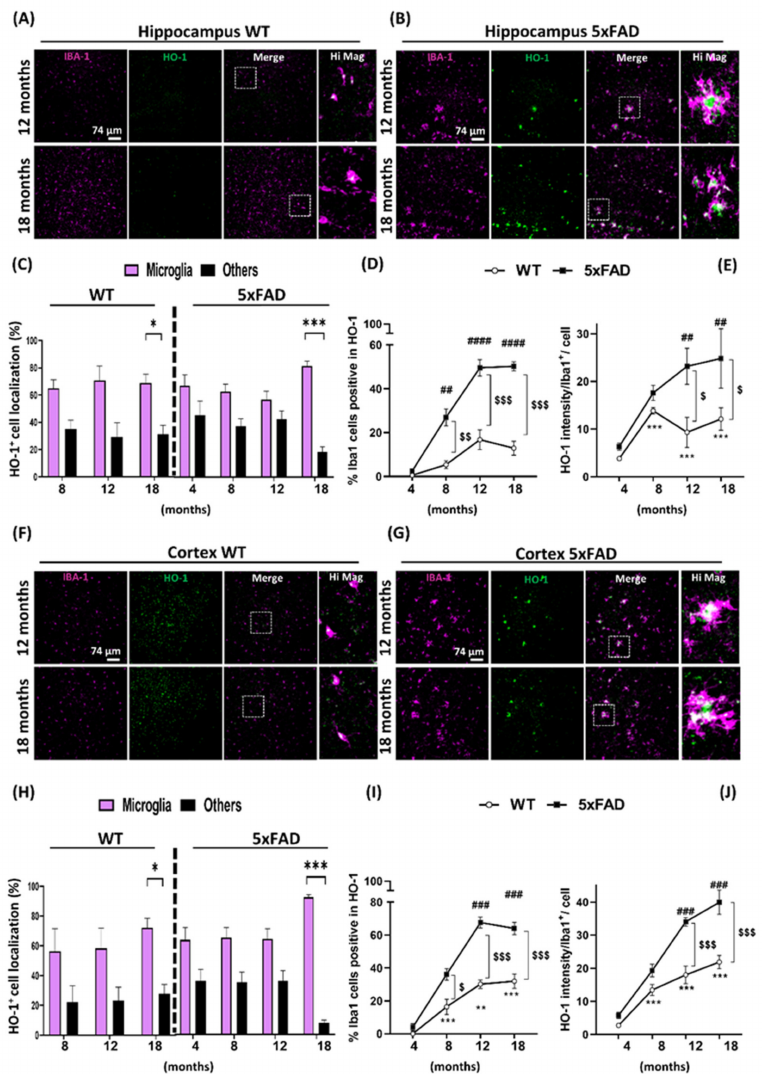
Figure 2. Microglial HO-1 is overexpressed in the hippocampus and the cortex with aging in 5xFAD. ( A , B ) 40x representative immunofluorescence images of microglia as Iba1 + (magenta) and HO-1 (green) and the merge image (white) in the hippocampus of WT and 5xFAD mice, respectively, at 12 and 18 months of age. ( C ) Specific cell localization of HO-1 + staining in microglia (magenta) or other cells (black) expressed as percentage in the hippocampi of WT or 5xFAD mice at the different ages; * p < 0.03 and *** p < 0.001 compared to the percentage of HO-1 + staining in microglia. ( D ) Percentage of total microglial cells expressing HO-1 in WT and 5xFAD mice at different ages. ( E ) HO-1 mean intensity in Iba1 + microglial cells was higher in 5xFAD mice and increased with aging. *** p < 0.002 compared to 4-month-old WT mice; ## p < 0.002, ### p < 0.001 compared to 4-month-old 5xFAD; $ p < 0.03, $$ p < 0.002 and $$$ p < 0.001 5xFAD mice compared to aged-match WT controls. 40 × representative immunofluorescence images in the brain cortex of WT ( F ) and 5xFAD ( G ) mice at 12 and 18 months old. ( H ) Specific cell localization of HO-1 + staining in microglia (magenta) or other cells (black) expressed as percentage in the cortex of WT or 5xFAD mice at the different ages. * p < 0.03 and *** p < 0.001 compared to the percentage of HO-1 + staining in microglia. ( I ) Percentage of total microglial cells expressing HO-1 in WT and 5xFAD cortex at different ages. ( J ) Cortex HO-1 mean intensity in Iba1 + microglial cells in WT and 5xFAD mice with aging. ** p < 0.002, *** p < 0.001 compared to 4-month-old WT mice; ### p < 0.001 compared to 4-month-old 5xFAD; $ p < 0.03, $$$ p < 0.001 5xFAD mice compared to aged-match WT controls. Data represent mean ± S.E.M. ( N =